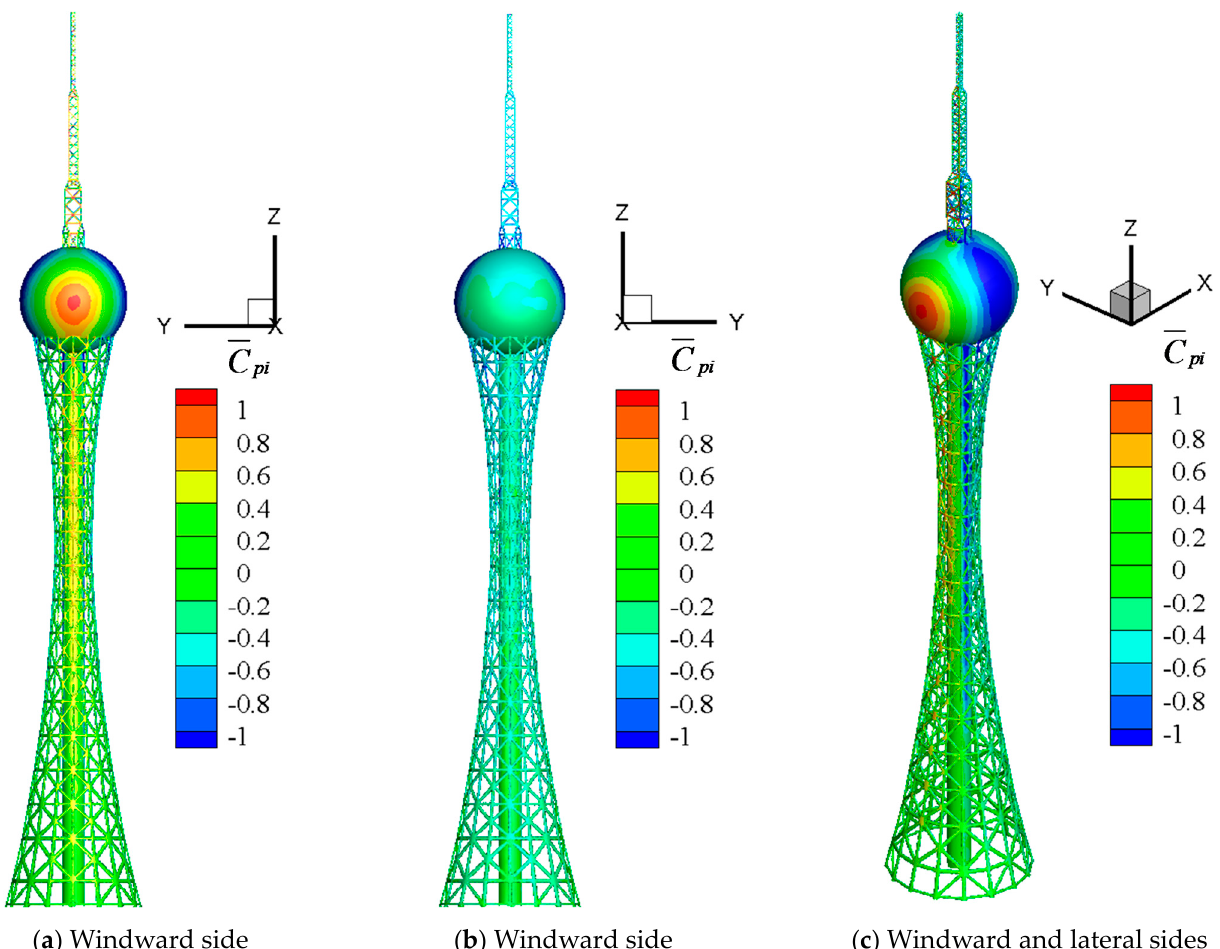
Figure 22. Mean wind pressure coefficient distribution of the TV tower with the grid structure.